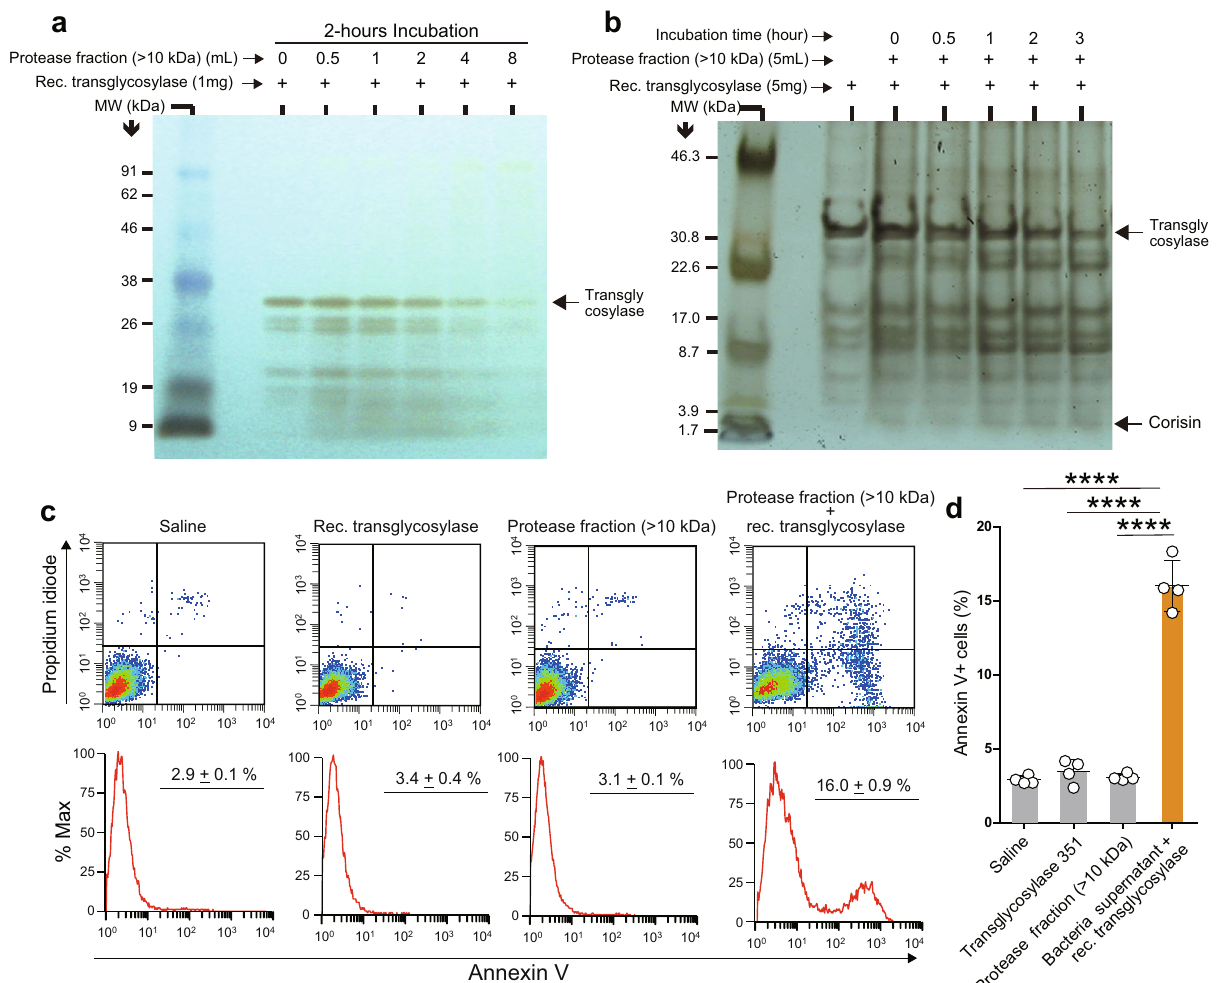
Fig. 3 A bacterial secreted product degrades transglycosylase to induce apoptosis of lung epithelial cells. a A sodium dodecyl sulfate-polyacrylamide gel stained with silver staining after completing the electrophoresis of a reaction mixture containing digestion buffer, recombinant transglycosylase, and varying doses of the protease fraction (>10 kDa) prepared from Staphylococcus nepalensis culture supernatant and incubated at 37 °C for 2 h. A representative image from two independent experiments with similar results is shown. b A sodium dodecyl sulfate-polyacrylamide gel stained with silver staining after completing the electrophoresis of a reaction mixture containing digestion buffer, recombinant transglycosylase, and a dose of the protease fraction (>10 kDa) prepared from Staphylococcus nepalensis culture supernatant incubated at 37 °C at different time intervals. A representative image from two independent experiments with similar results is shown. c , d Flow cytometry analysis to evaluate apoptosis of A549 alveolar epithelial cells after treatment with the indicated reaction mixture. N = 4 in each group. Data are the mean ± S.D. Statistical analysis by ANOVA with a post